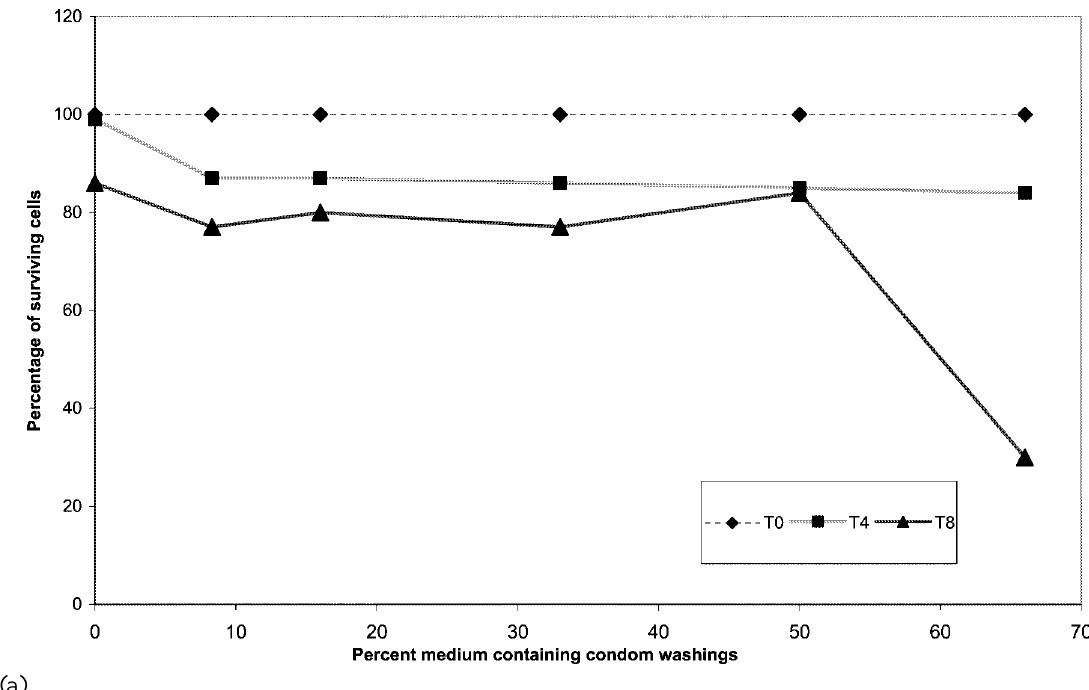
Fig. 1. Cell survival determined from Crystal Violet assay following exposure of cells to washings derived from: (a) non-lubricated condoms, (b) lubricated condoms, and (c) flavored